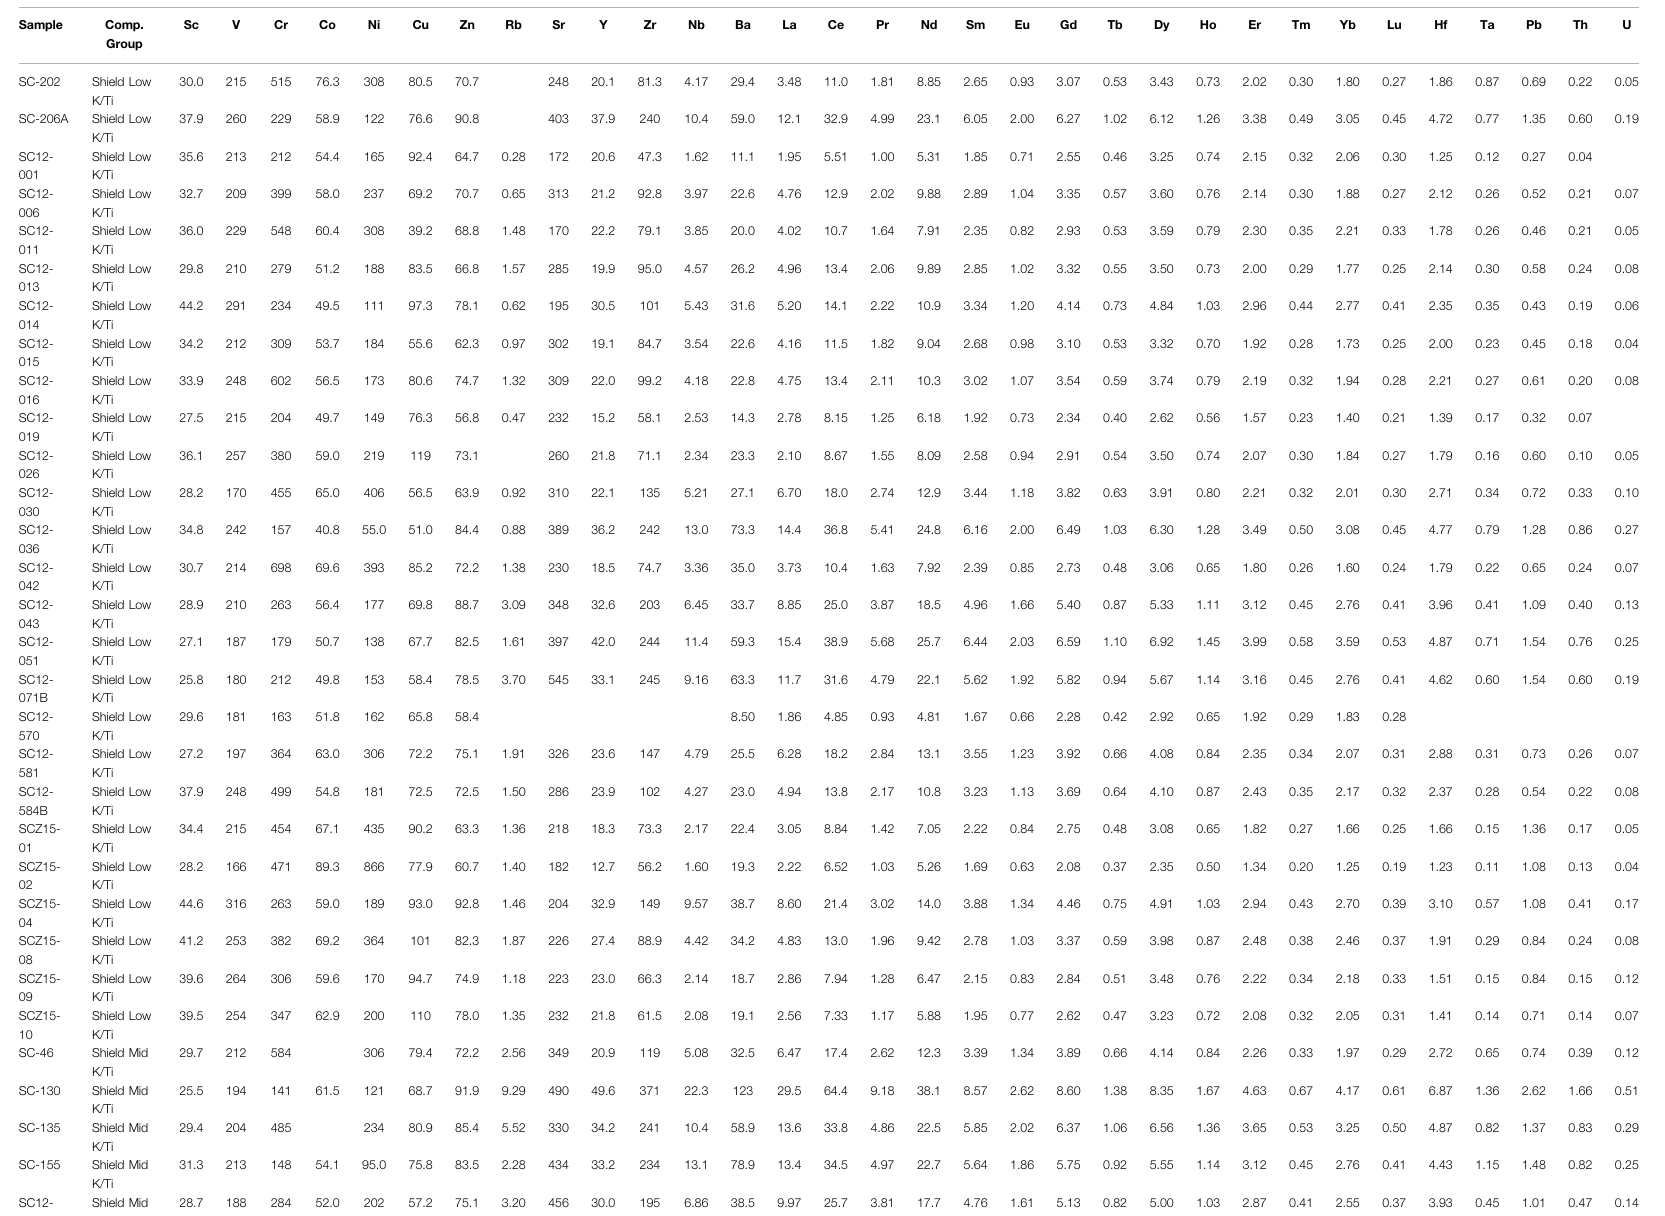
TABLE 2 | ( Continued ) Trace element abundances of Santa Cruz lavas, reported in parts per million (ppm). One replicate analysis (indicated by “ re ” ) is